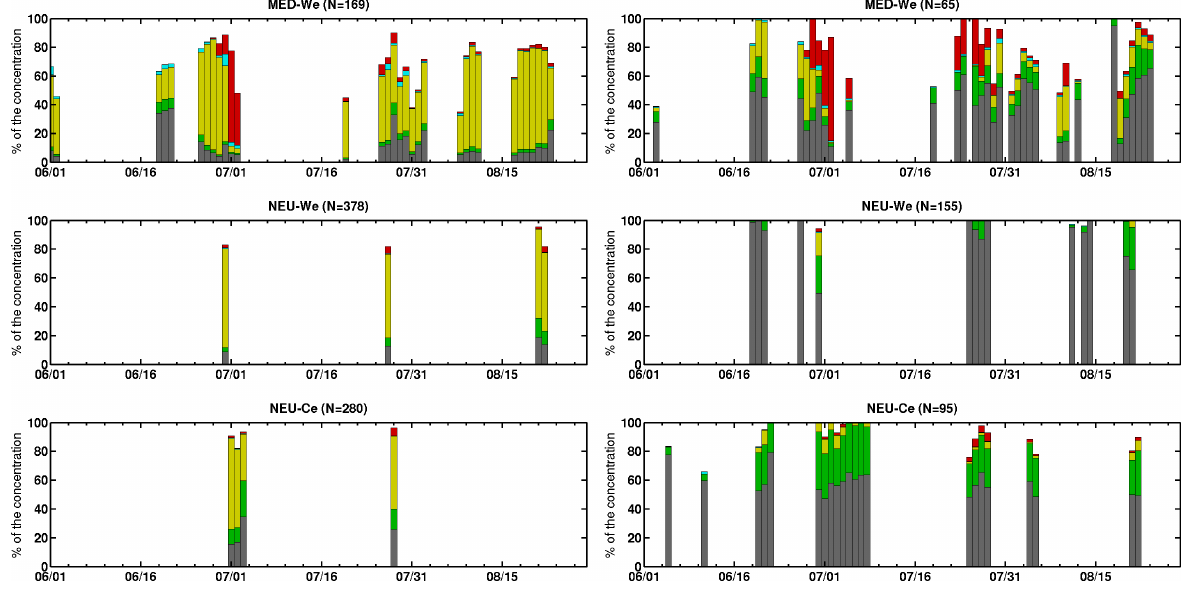
Figure 15. Same as Fig. 14 but when exceedances of the daily air quality threshold are detected by both observations and model after optimization of the background concentration baseline at the considered